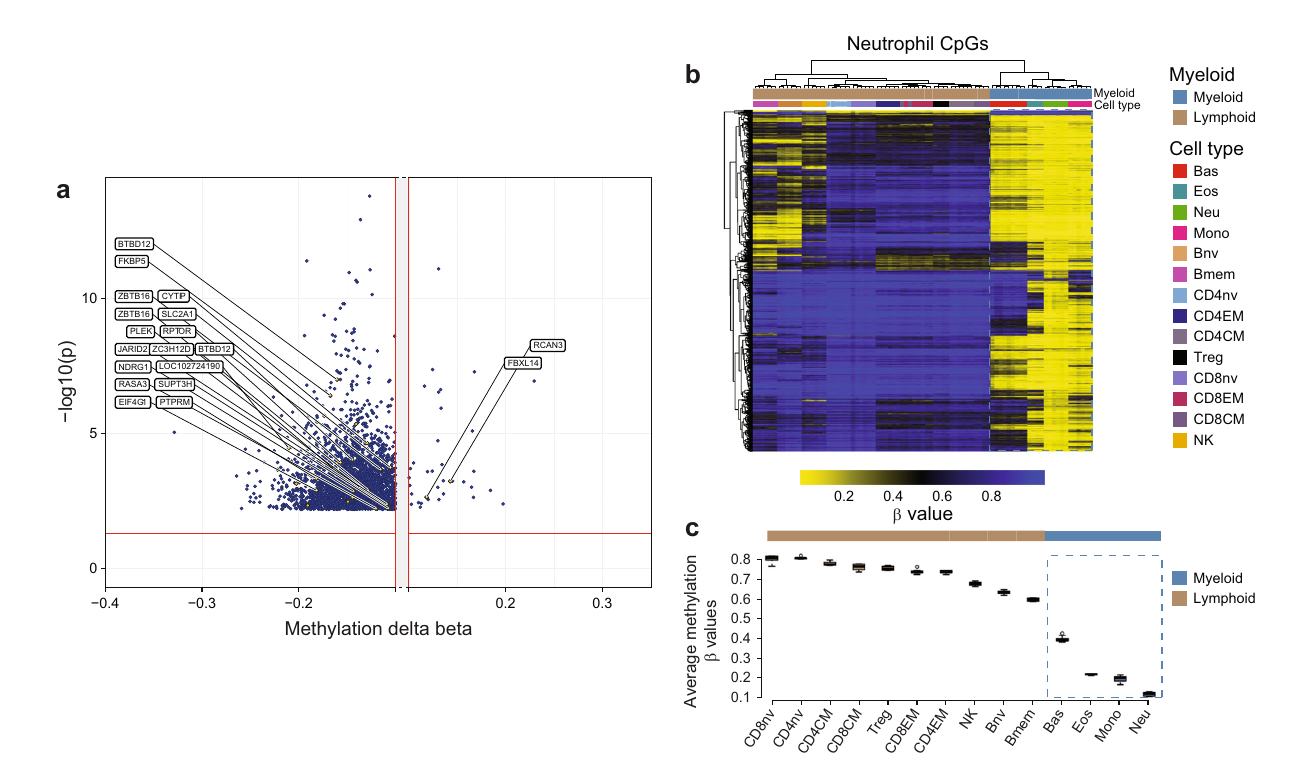
Fig. 2 | DEX-related neutrophil-speci fi c DNA methylation. a Volcano plot showing the output of CellDMC analysis of 2621 DEX associated CpG loci with nominally signi fi cant (FDR<0.05) interactions with neutrophil proportions. Plot- ted are the average difference in methylation beta value (delta beta) between DEX exposed and DEX non-exposedsubjects (x-axis) and the p value for the interaction ofmethylationandneutrophilproportion(y-axis).Hypomethylatedlocihavelower methylation beta values in exposed versus non-exposed (left sideofvolcano plot). The plot is truncated at |delta beta|>0.1. CpGs associated with genes included in theNDMIscorearehighlighted. b